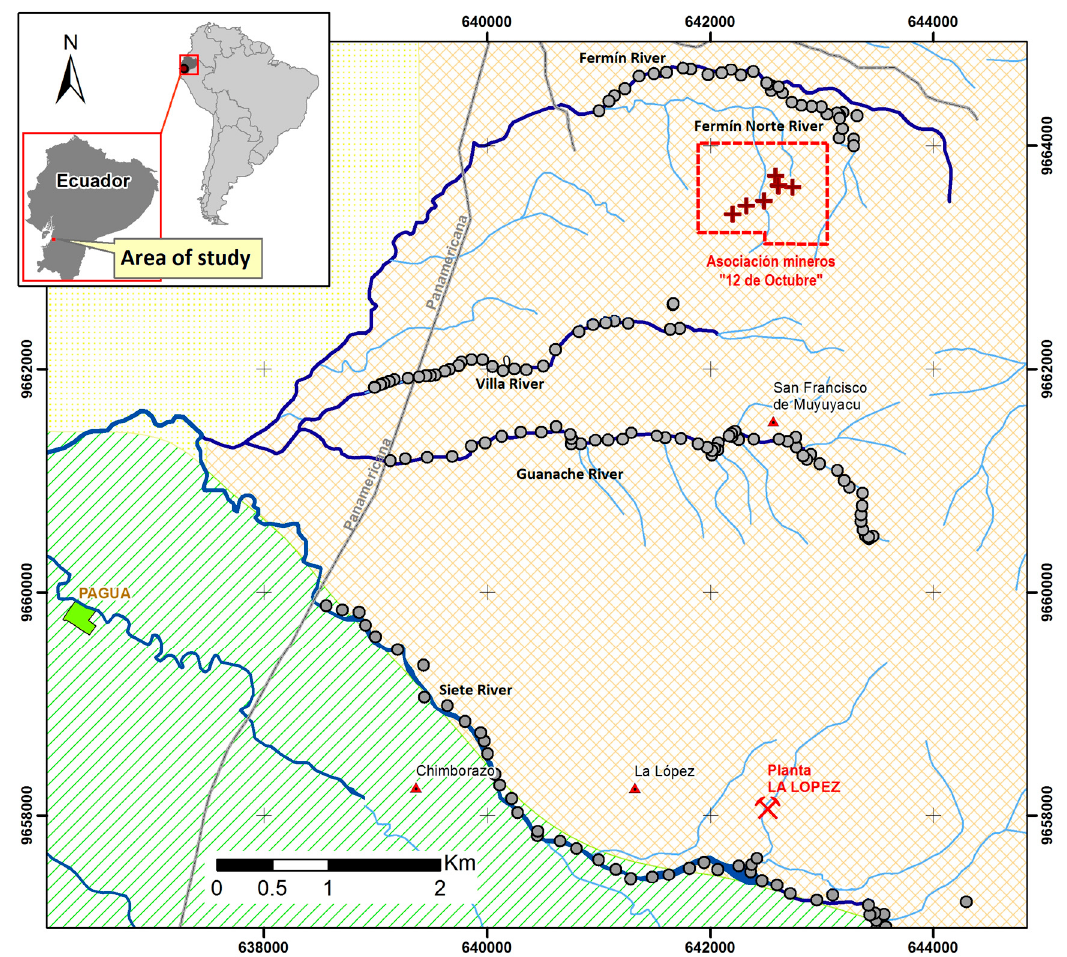
Figure 2. Area of Figure 2. Area of study.